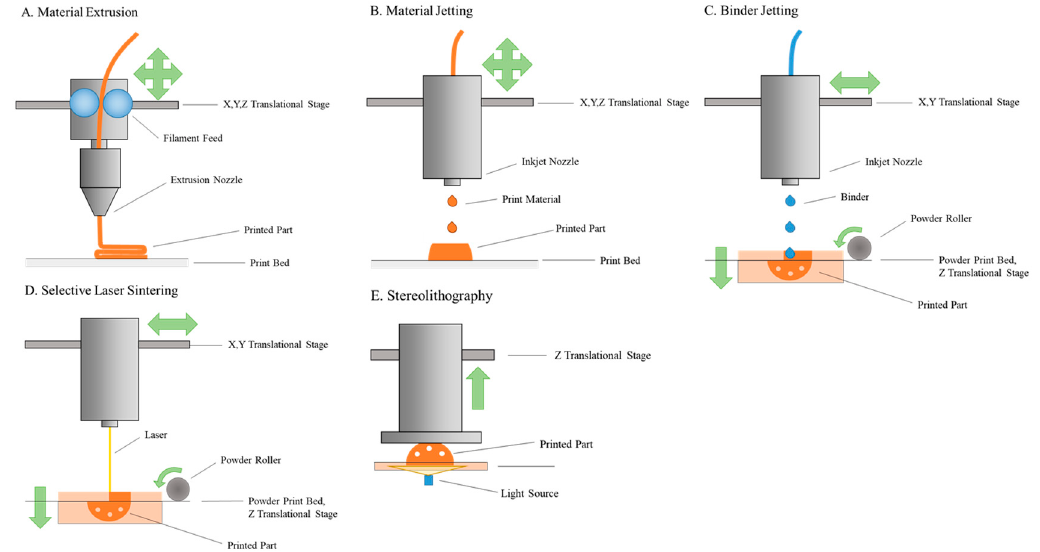
Figure 1. Typical additive manufacturing mechanisms. Additive manufacturing techniques are classified by their deposition of material in a layer-by-layer fashion. Material extrusion ( A )